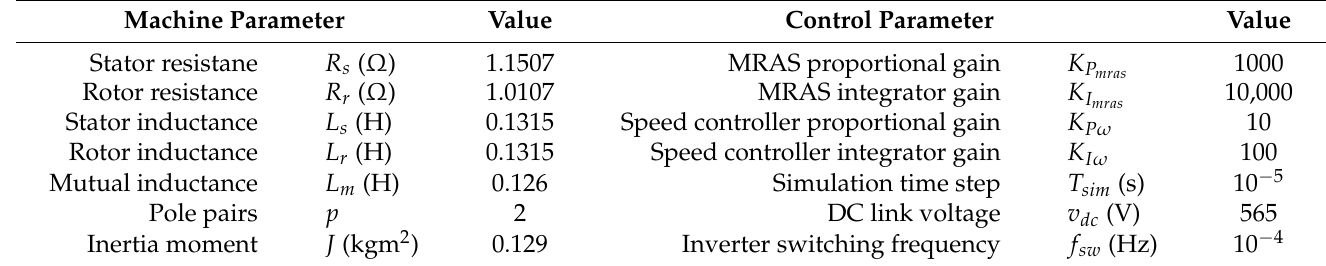
Table 1. Induction machine parameters and control